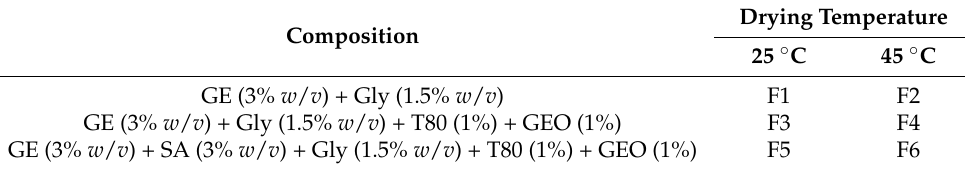
Table 1. Composition of the edible